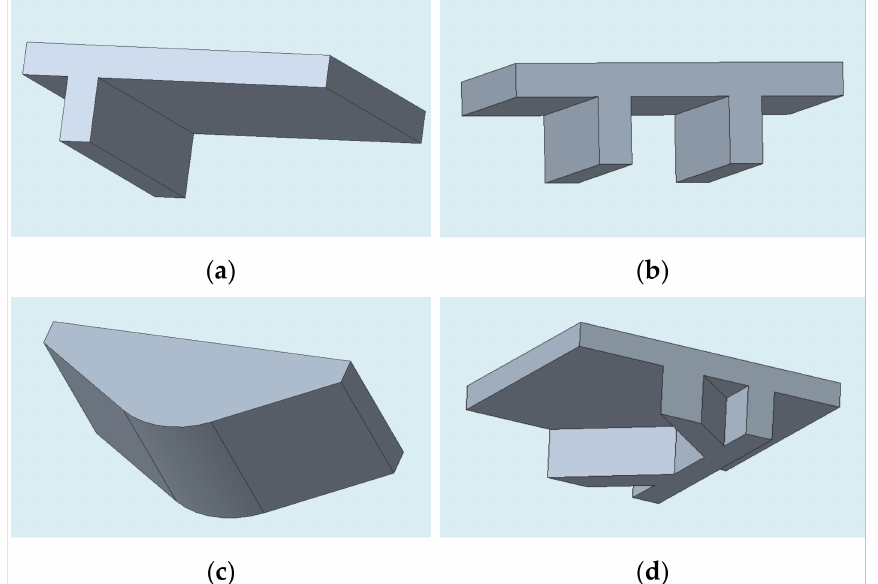
Figure 3. The more common track shoe shapes are as follows: ( a ) T-shape track shoe; ( b ) π -shape track shoe; ( c ) V-shape track shoe; ( d ) K-shape track shoe.